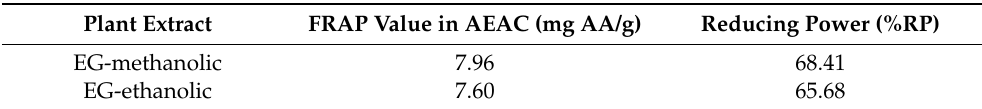
Table 5. FRAP value in AEAC (mg AA/g) and reducing power (%RP).